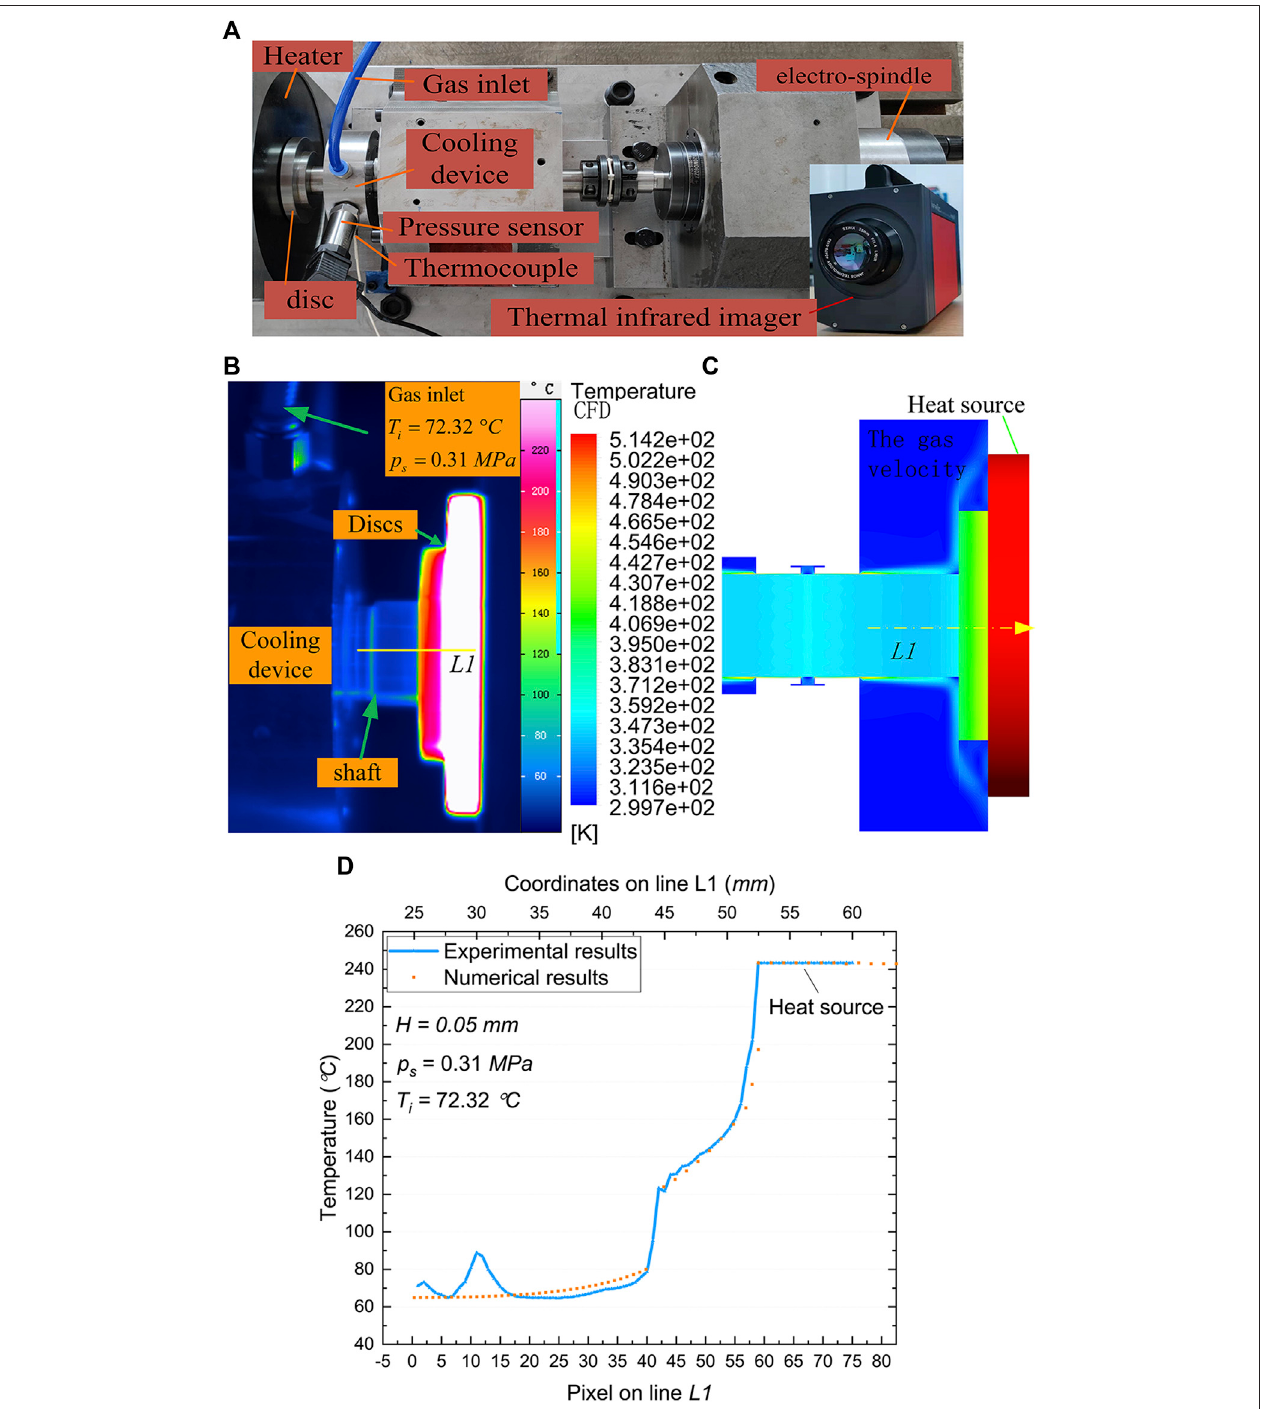
FIGURE 7 | Experimental setup and results. (A) Test rig for the measurement of the temperature fi eld of the rotor. (B) Experimental results. (C) Numerical results. (D) Experimental and numerical temperatures on the line L1.